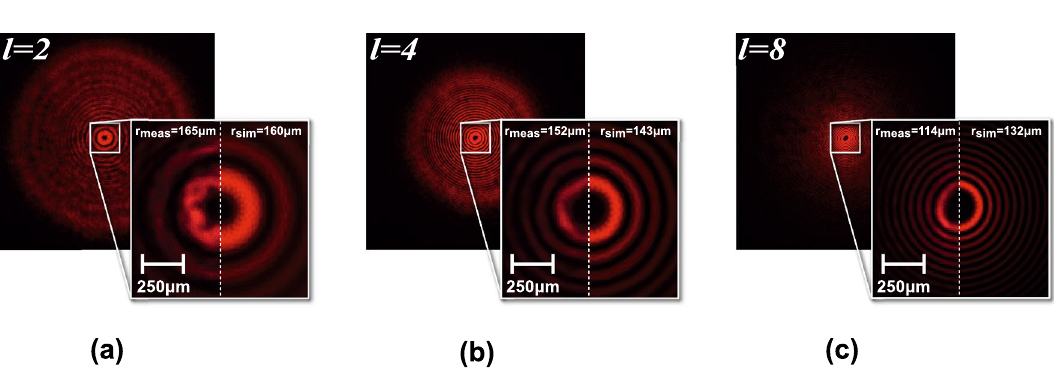
Figure 7. Bessel Gauss beam intensity pattern generated by the DSA at z = 50 cm for different topologies compared with the corresponding simulated results (superposed in the right part of zoomed section). ( a ) l = 2. ( b ) l = 4. ( c ) l = 8. The images show the light intensity projected directly onto the camera CMOS detector at 50 cm distance from the DSA. The radius of the for both simulations and measurements are